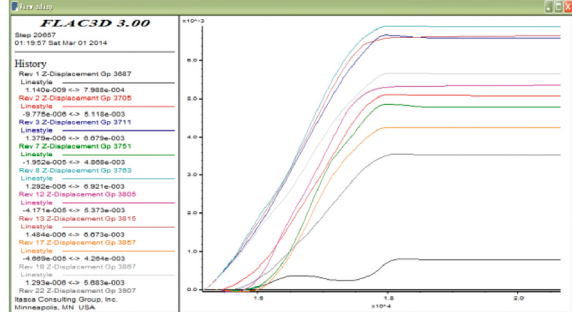
Figure 4: The vertical deformation for each history point of 10–20 type.